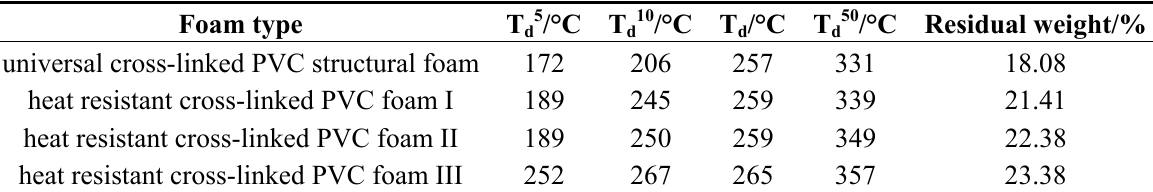
Table 2. TGA values of foam